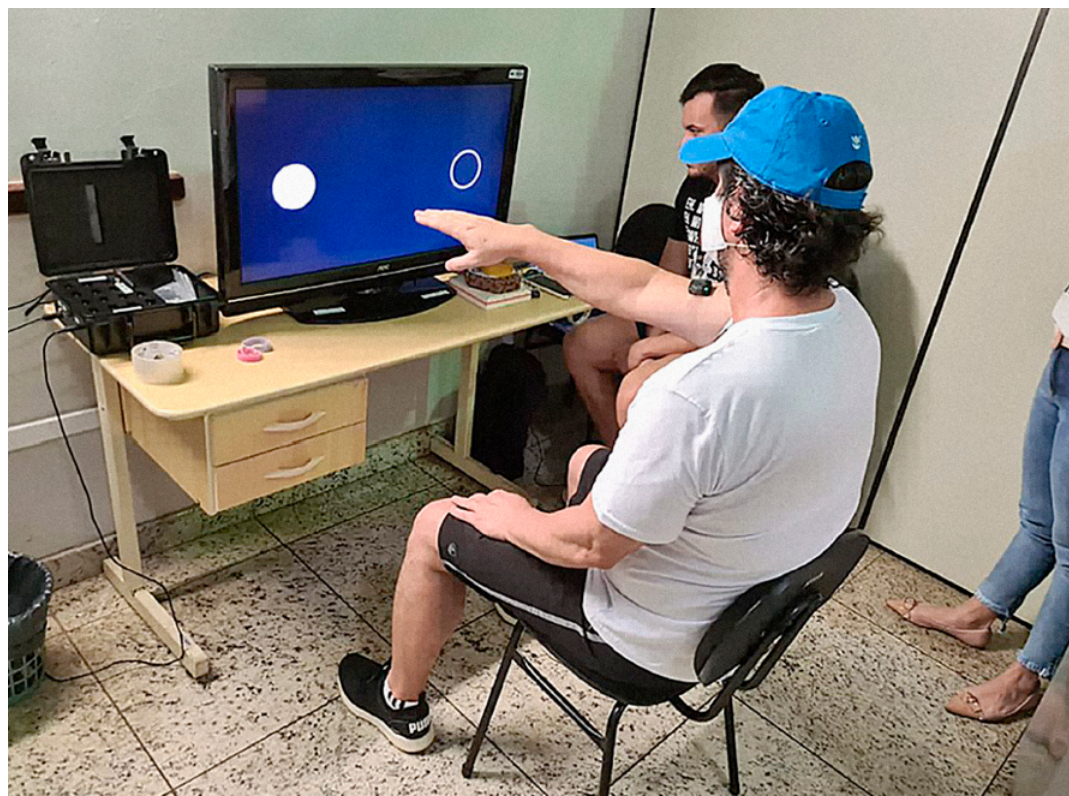
Figure 1. Participant’s position and choice reaction time